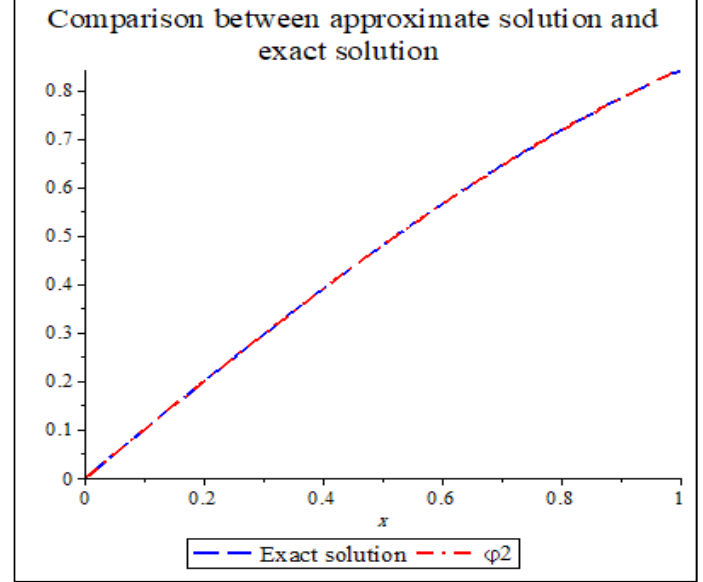
Figure 5. Comparison of the exact solution and the approximate solution 𝜑 (cid:2870) in Example 5.